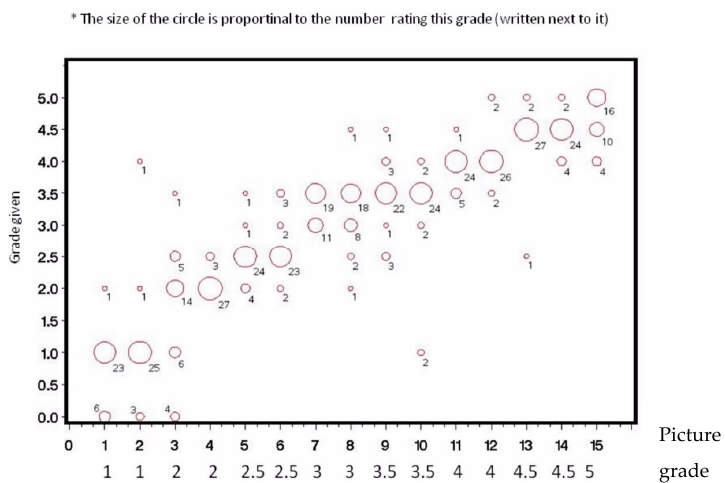
Figure 2. Distribution of 30 ophthalmologists’ grading for the 15 photographs at Time 1.